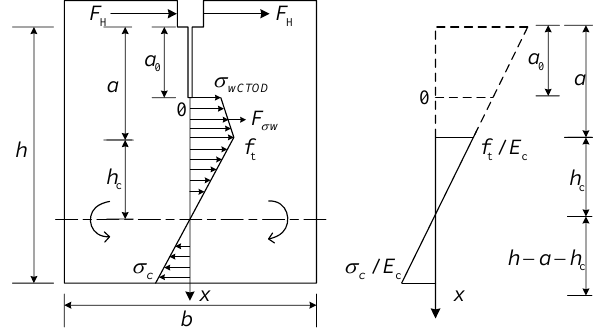
Figure 2. Stress and strain distribution in a ligament cross section of a wedge-splitting specimen.